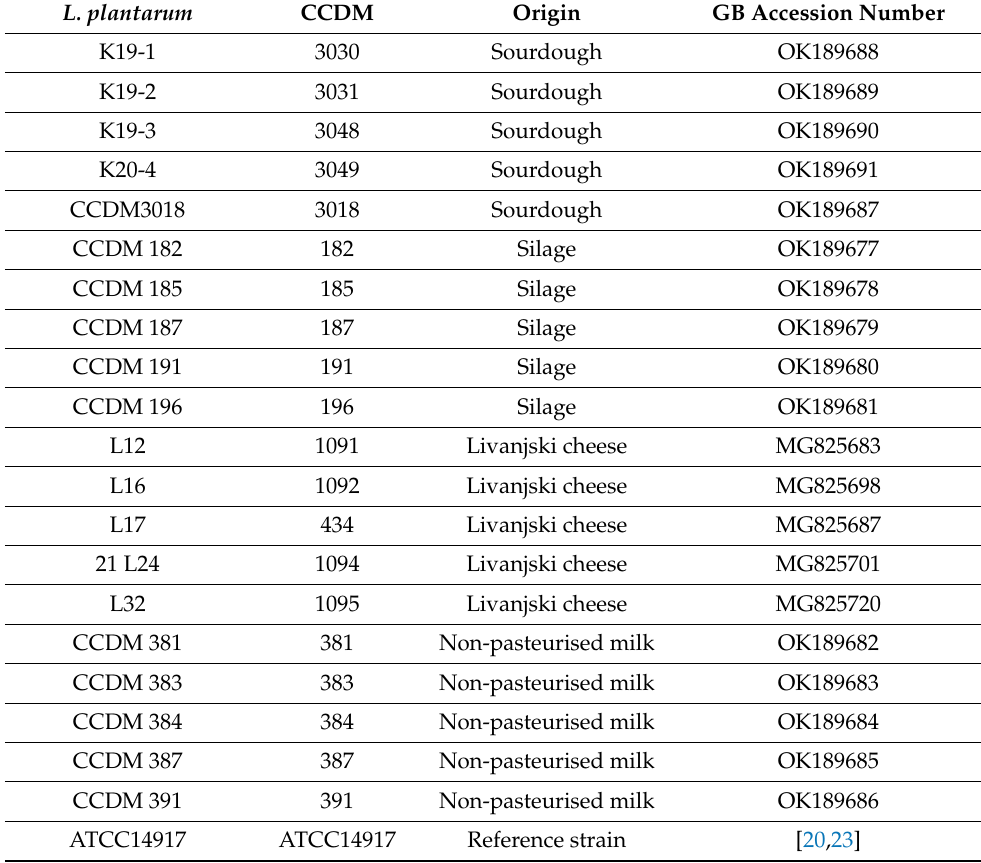
Table 1. The list of strains of Lactiplantibacillus plantarum from the CCDM collection, including their origins and accession